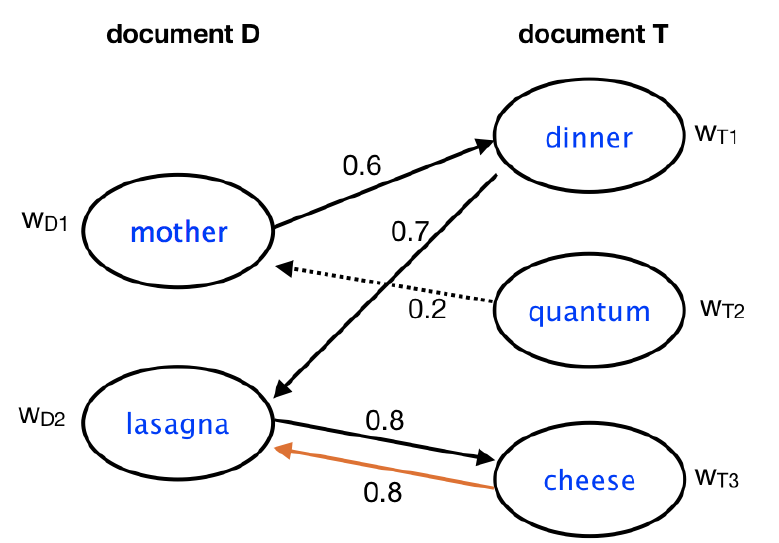
Figure 1. A graph with the significant relations between documents D and T . For a detailed explanation refer to Appendix